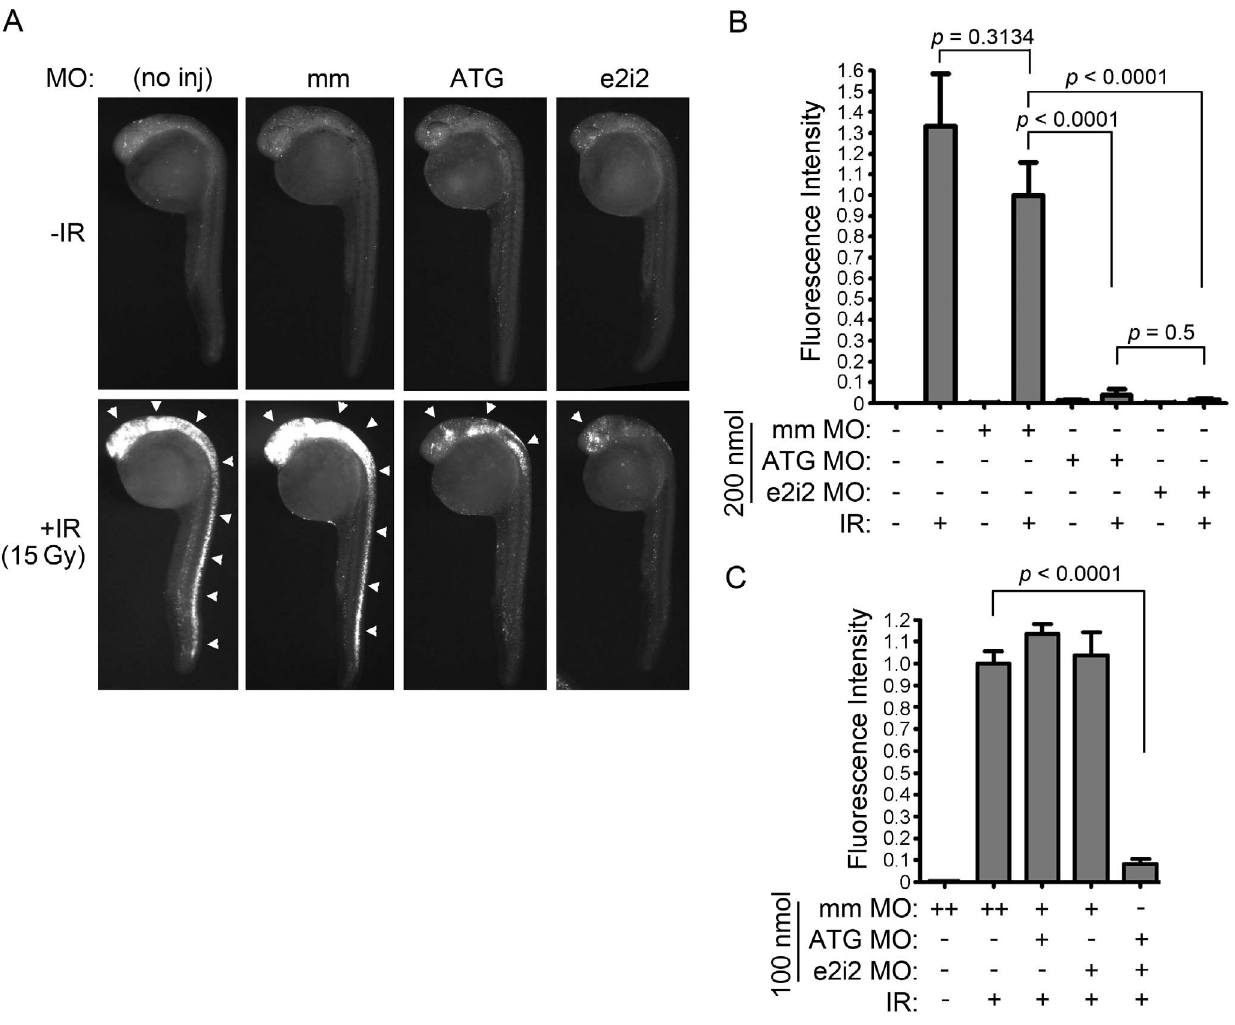
Figure 1. Bad is required for IR-induced apoptosis in zebrafish embryonic neural tissue. (A) Shown are lateral views of 27-hpf embryos (head is top left in each panel) either uninjected or injected with 200 nmol of bad ATG , bad e2i2 or mismatch (mm) MO. Half of each group of embryos were exposed to 15 Gy IR, and all were analyzed by the Casp3 assay. In control embryos (no inj and mm), IR-induced apoptosis occurs predominantly in the brain and all along the spinal cord (white arrowheads), whereas in bad -deficient embryos (ATG and e2i2), residual apoptosis is only observed in the head (arrowheads). (B) Fluorescence intensity, reflecting level of Caspase 3 activity, was measured in the spinal cords of at least 10 embryos from each group in (A) as previously described [34]. The fluorescence intensity in irradiated mismatch-MO-injected embryos was normalized to 1. (C) One-cell stage zebrafish embryos were injected with 100 nmol of bad ATG , bad e2i2 or mm MO as indicated (‘‘ ++ ’’ indicates that 200 nmol was injected to keep total concentration of MO constant between experimental groups) and irradiated and analyzed as in (A-B). Data represent one experiment, and the experiment was independently performed three times with similar results.